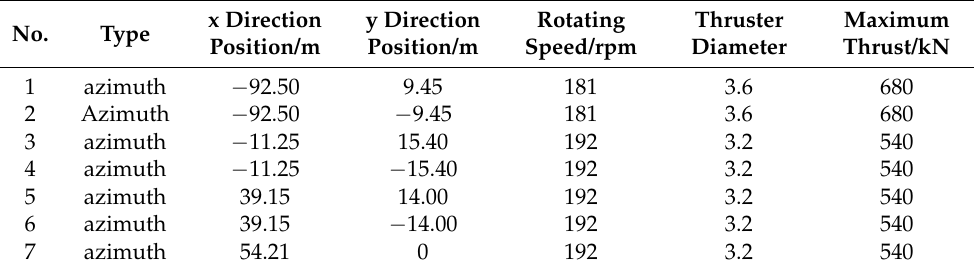
Figure 6. The arrangement and position of the HYSY201 thrusters. Table 2. The position of the thrusters for HYSY201.